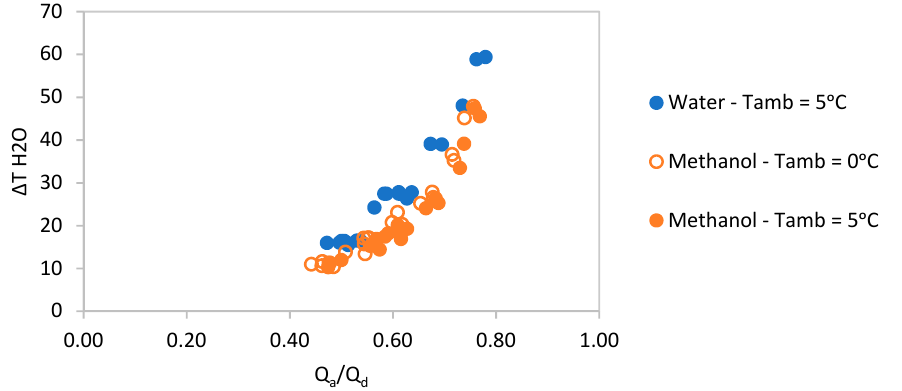
Figure 8. Performance of water and methanol pairs performance for T amb = 0, 5 ◦ C, T a = 45, 50, 55 ◦ C and T d = T a + 2, 4, 6, 8, 10 ◦ C .